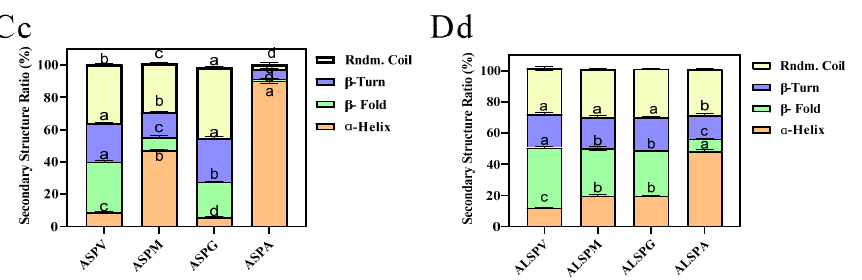
Figure 4. Far–UV CD spectra and secondary structure analysis of proteins in visceral mass, mantle, gill, and adductor. Figure 4 ( A – D ) showed the far–UV CD spectras of WSP, SSP, ASP and ALSP in different parts of oyster, respectively. Figure 4 ( Aa – Dd ) showed the secondary structure profiles of WSP, SSP, ASP and ALSP in different parts of oyster, respectively. Different superscripts in the same color indicate significant differences ( p <